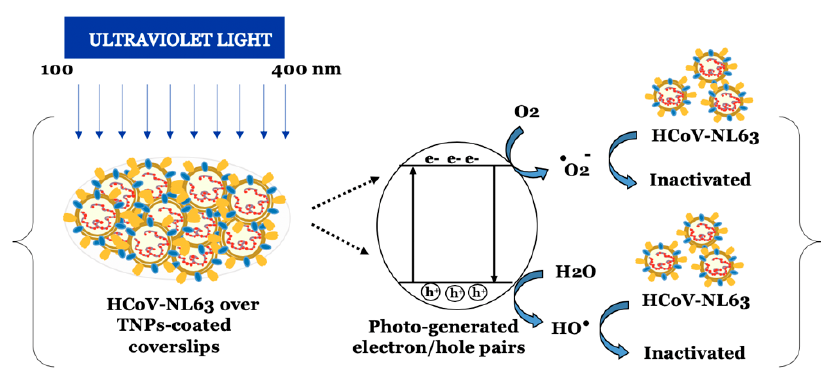
Figure 6. Schematic illustration of photocatalytic inactivation of HCoV-NL63 principle. Irradiation with UV light generates specific “electron-hole (e - -h + )” pair, and reactive oxygen species (ROS), including hydroxyl and superoxide radicals on the surface of TNPs. These ROS have strong oxidative ability, which can inactivate viruses through oxidative damage.